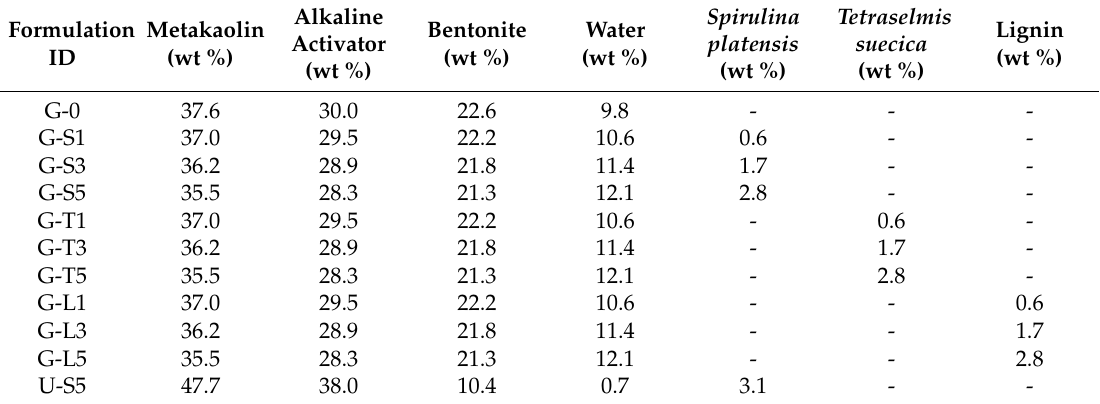
Table 3. Mixture proportions of cementitious geopolymer pastes for LDM